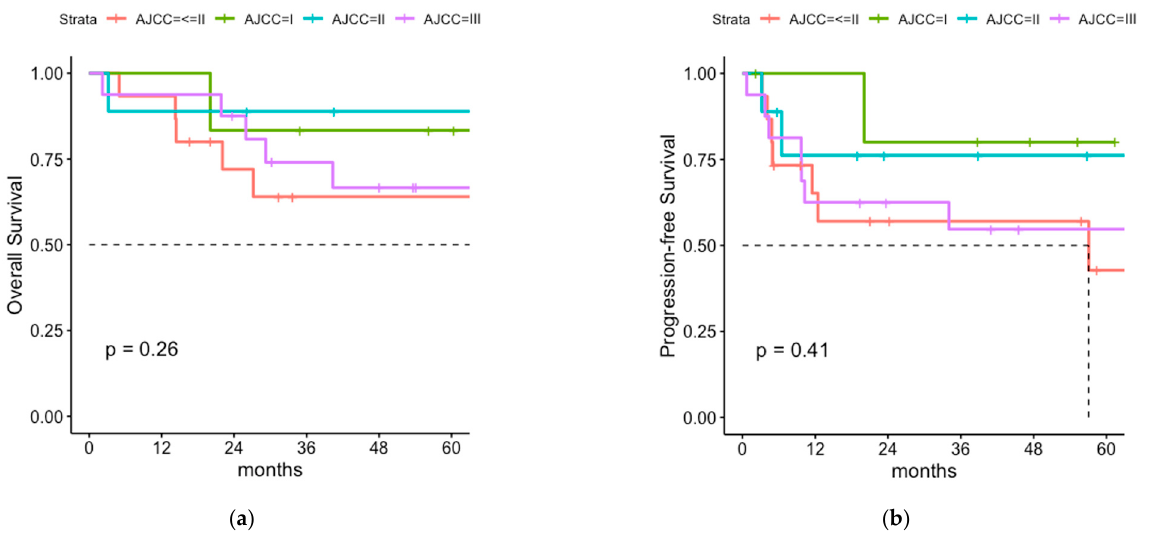
Figure A3. Stage-adapted ( a ) OS and ( b ) PFS of the subgroup of surgically staged patients only for stage I, stage II, stage ≤ II and stage III, according to AJCC-staging classification (n = 46).